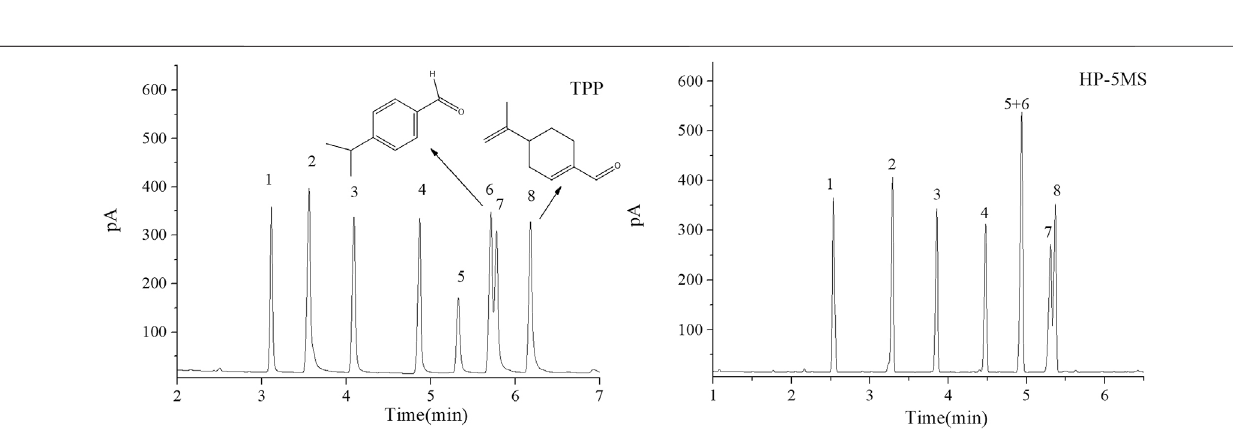
FIGURE 7 | GC chromatograms for separations of a mixture of aldehydes on TPP and HP-5MS capillary columns. Peaks:(1) sinensal, (2) n-nonanal, (3) citronellal, (4) n-decanal, (5) geranial, (6) cuminaldehyde, (7) neral, (8) perillaldehyde. Temperature program: 80 ° C (1 min) to 160 ° C at 10 ° C min − 1.